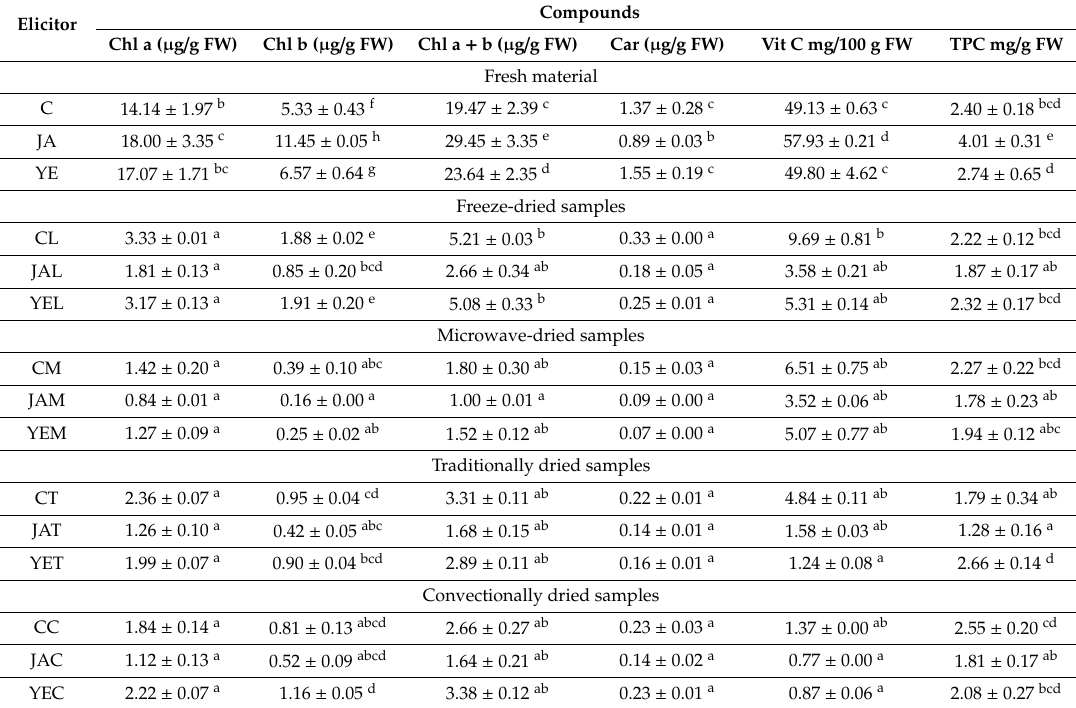
Table 3. E ff ect of elicitation and drying method on the content of bioactive compounds in lovage. Elicitor